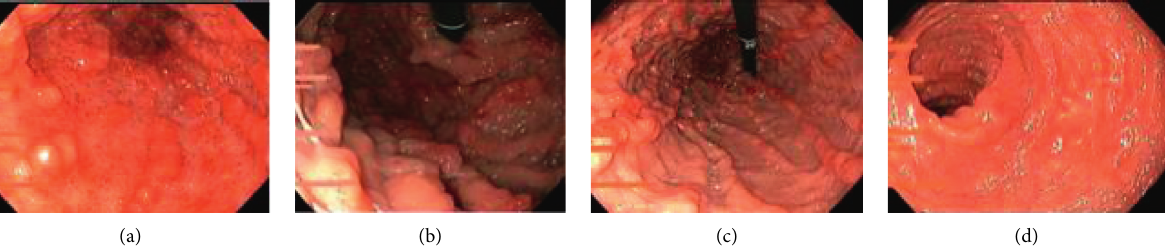
Figure 1: EGD scopy findings; panulcerative gastritis and ulcerative duodenitis. (a) Antrum, (b) fundus, (c) proximal body stomach, and (d) descending part of the duodenum.